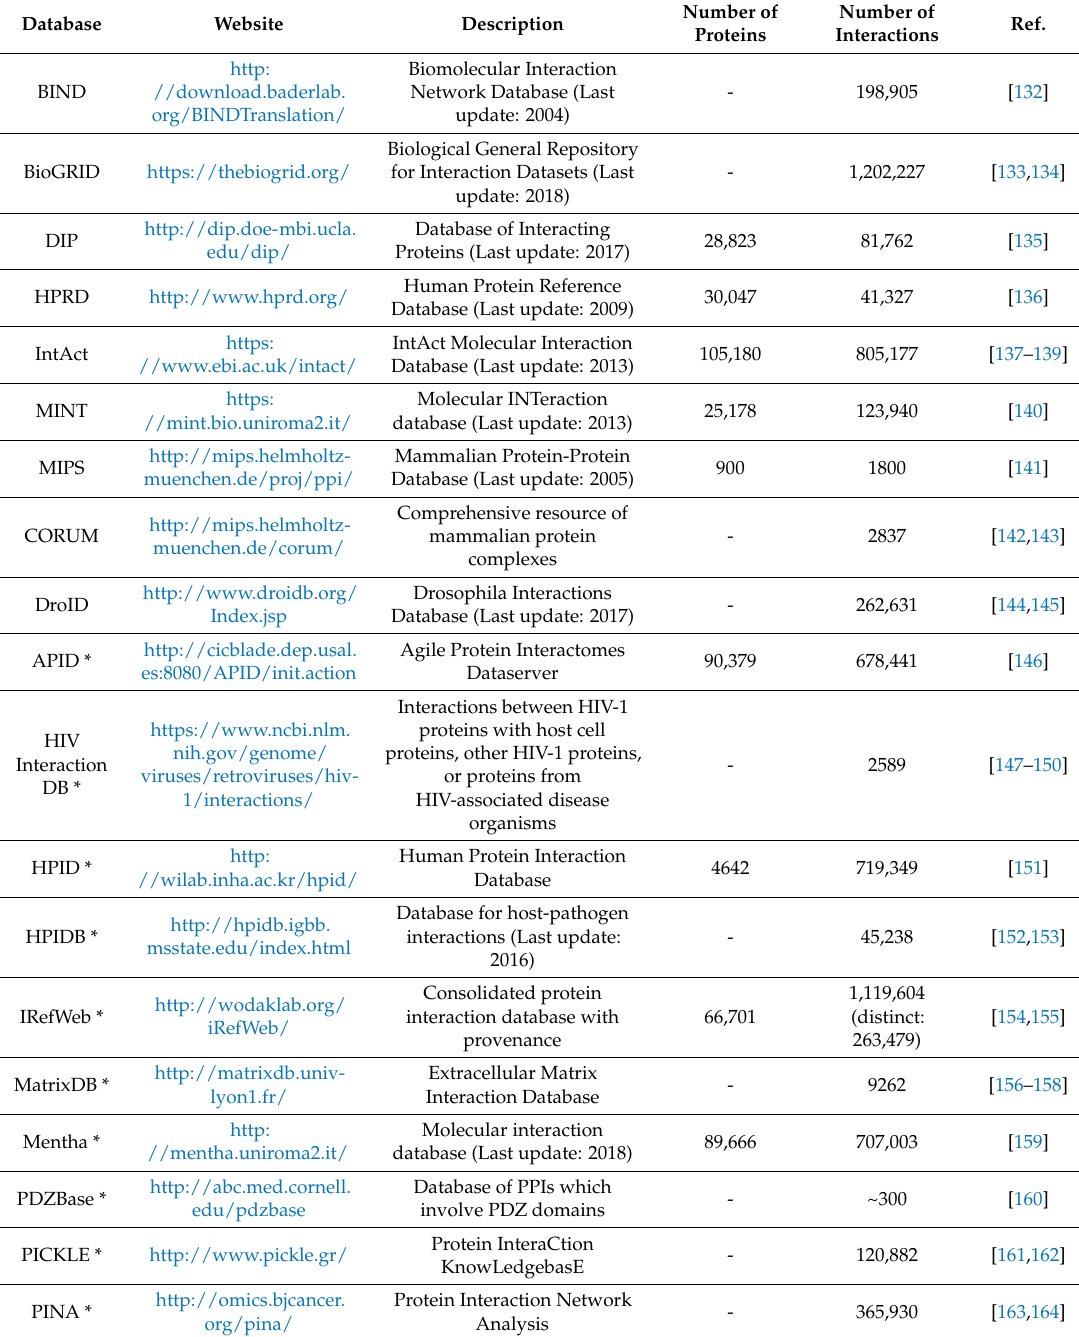
Table 2. Primary databases and meta-databases * for PPI